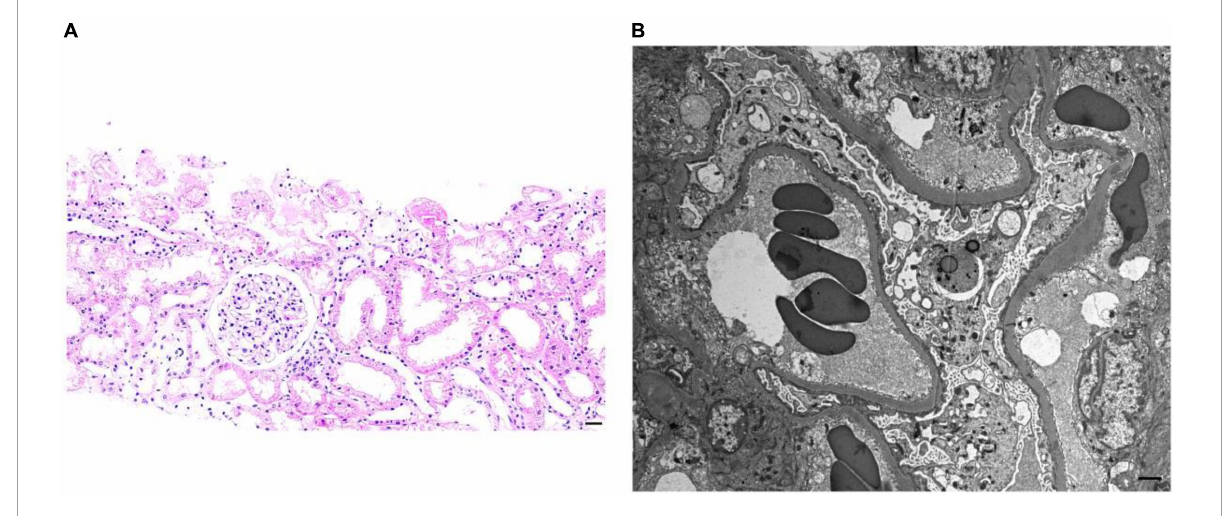
FIGURE1 Representative images of light microscopy and transmission electron microscopy (temtem) from the kidney biopsy of the patient. (A) Hematoxylin and eosin staining showed no significant changes in glomeruli, renal interstitium, and renal tubules (scale bar: 100 µ m). (B) Representative TEM showed the diffuse foot process effacement of podocytes, and no electron-dense deposition in the subepithelial, subendothelial, and mesangial compartments was detected (scale bar: 1 µ